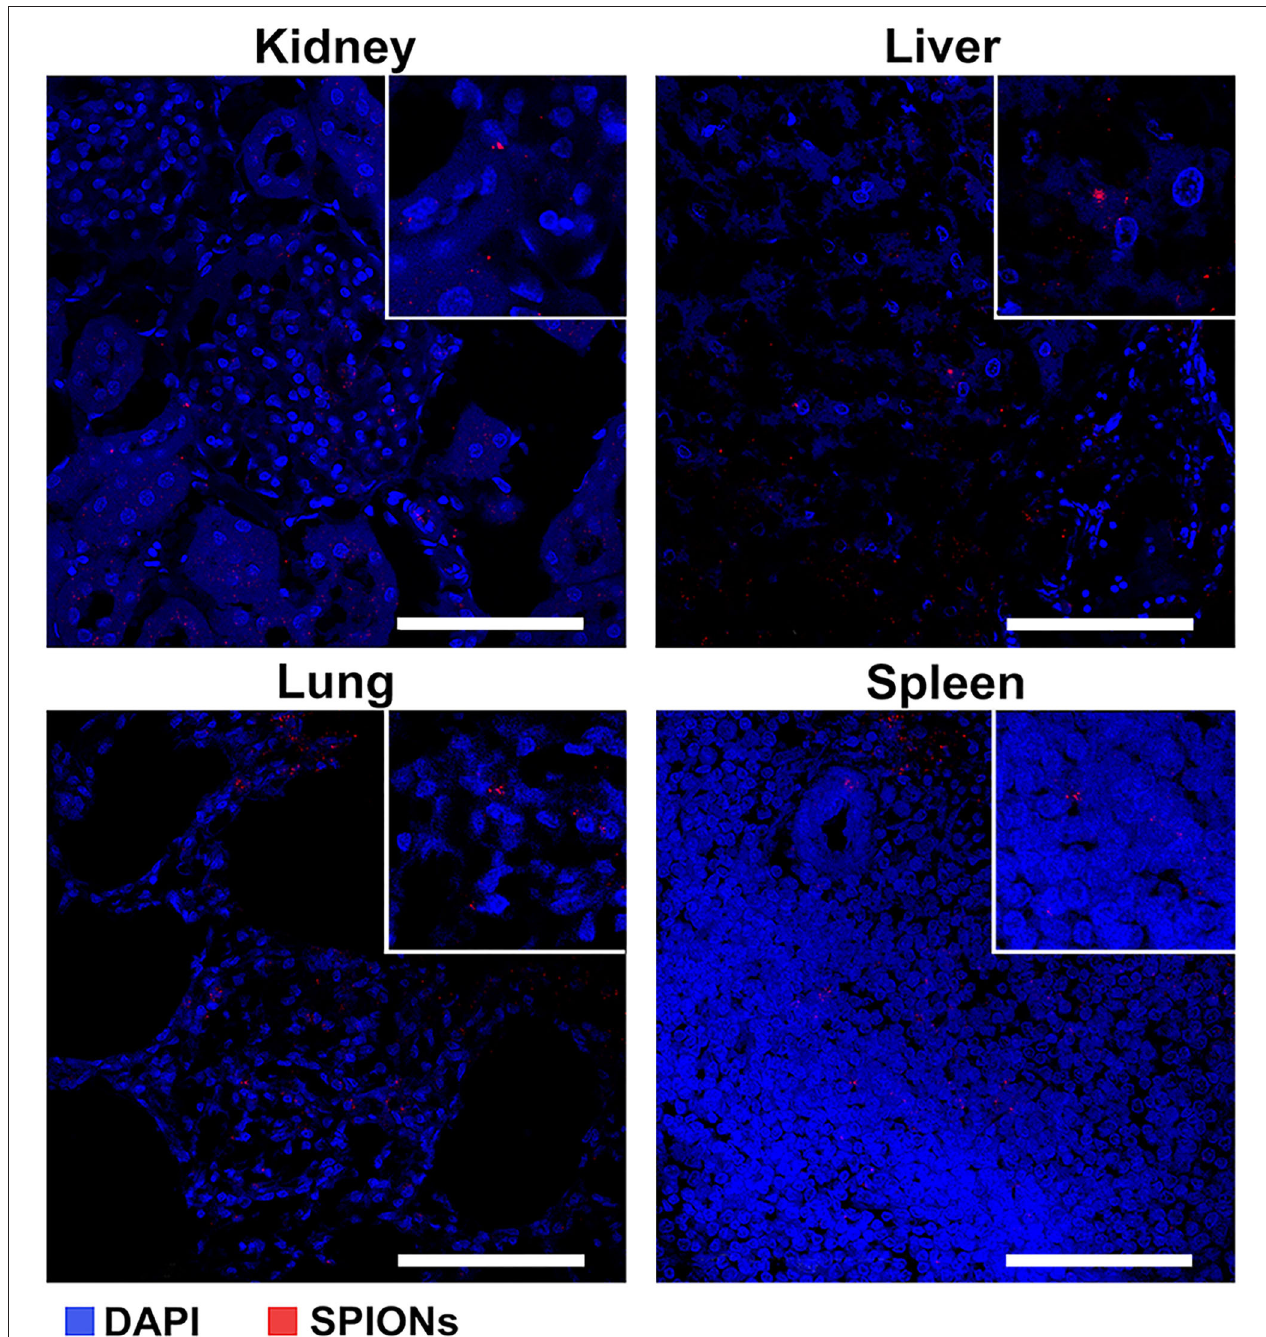
FIGURE 7 | Assessment of the SPION-labeled MCSs accumulation in different organs (kidney, liver, lung, and spleen). Nuclei were stained with DAPI (blue). SPIONs were detected by reflected laser scanning (red). Scale bars, 100 µ m.